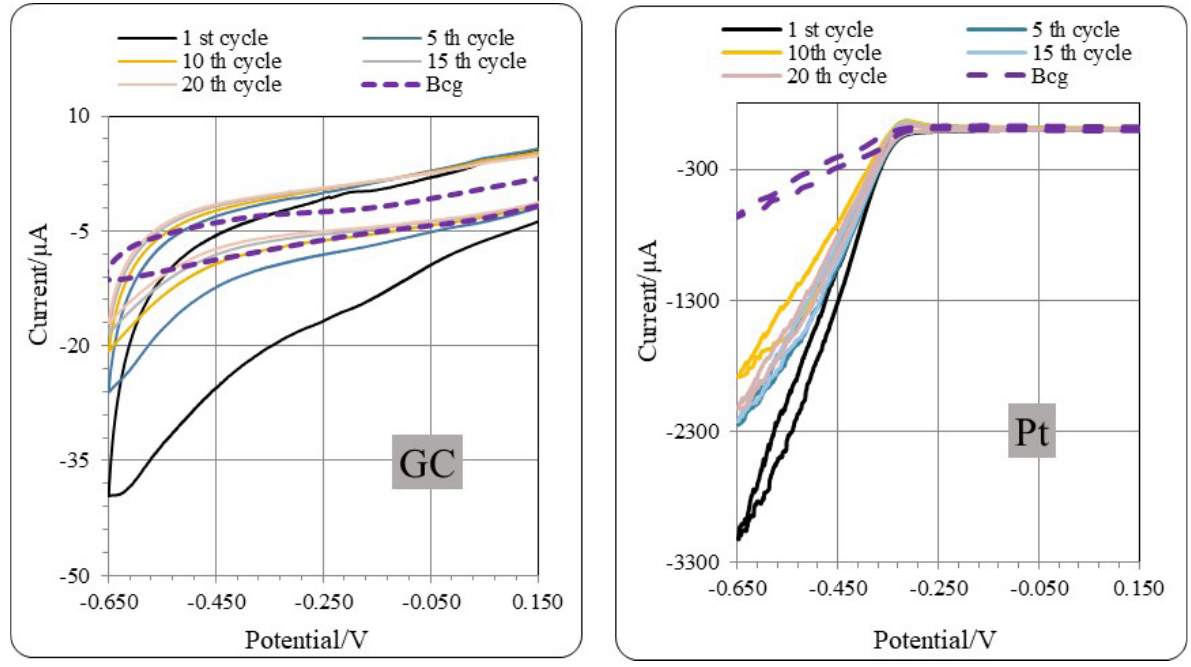
Figure 1: Cyclic voltammograms for Pt and GC electrodes in pyridine diazonium solution prepared ‘’in situ’’: (a) 1 st , b) 5 th , c) 10 th , d) 15 th , e) 20 th and f) Bcg scans. Scan rate 0.1 V s -1